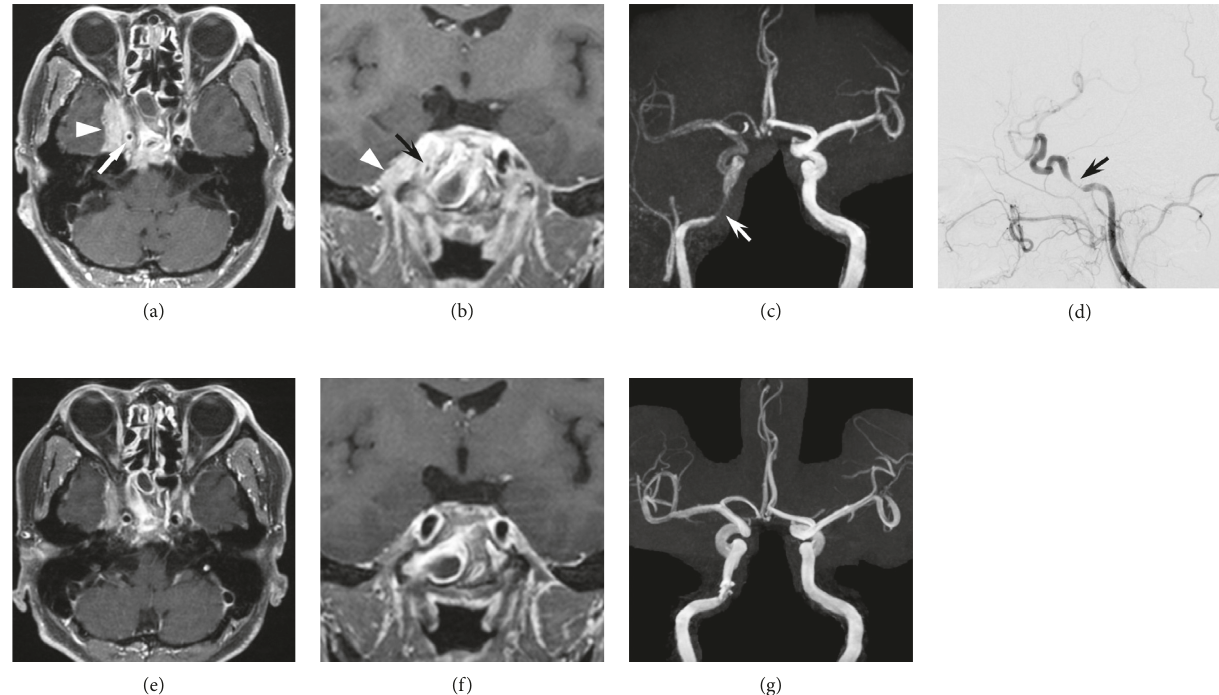
Figure 5: Imaging studies before immunosuppressive treatment (a–d) and 2 years after the initiation of the treatment (e–g). Gadolinium- enhanced T1-weighted MRI of the brain reveals thickening of enhanced dura mater extending from the cavernous sinus to the clivus on axial (a) and coronal (b) images (triangle). Narrowing at the C5 portion of the internal carotid artery (ICA) is apparent on axial (a) and coronal (b) MRI, MRA (c), and lateral cerebral angiography of the ICA (d) (arrow). Thickening of the dura mater and stenosis of the ICA improved on axial (e) and coronal (f) MRI and MRA